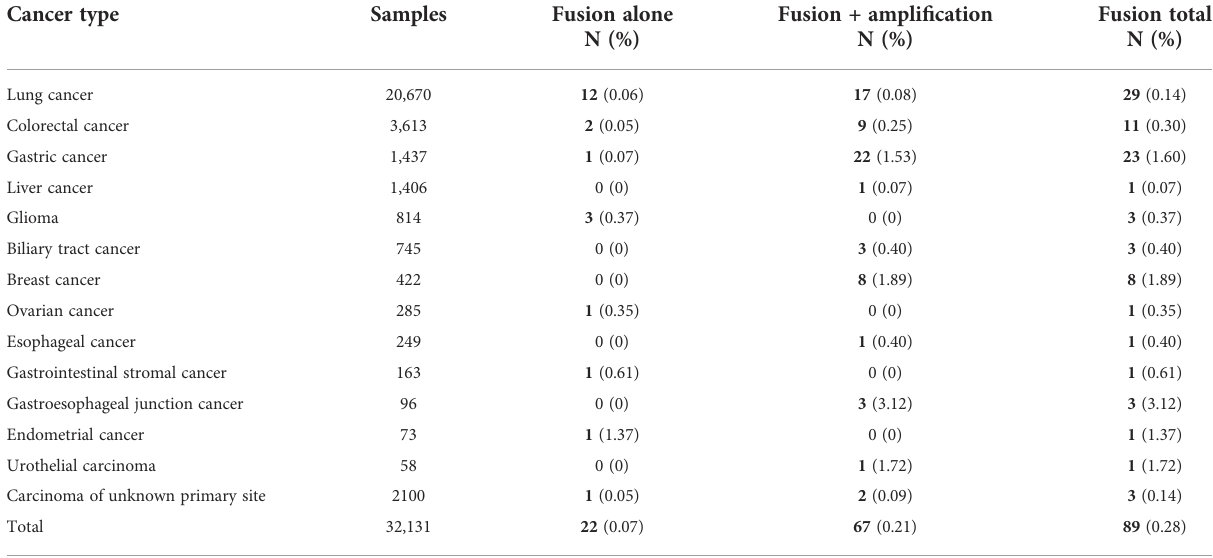
TABLE 2 Frequencies of ERBB2 alternations and relative distribution of alternation types in 89 ERBB2 fusion solid tumors from Chinese cohort.